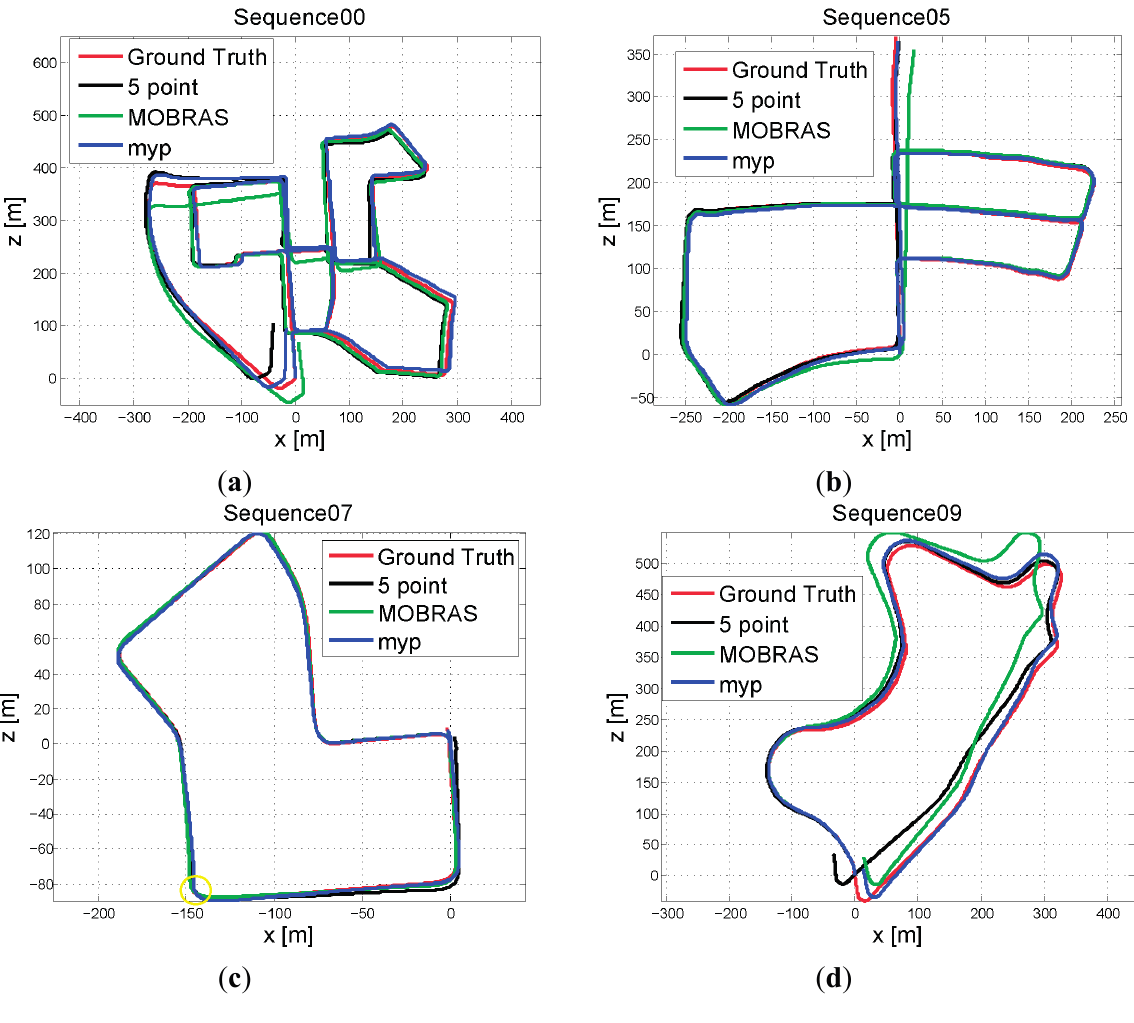
Figure 14. Exemplary estimated trajectories: Comparison between MYP, MOBRAS and 5-point